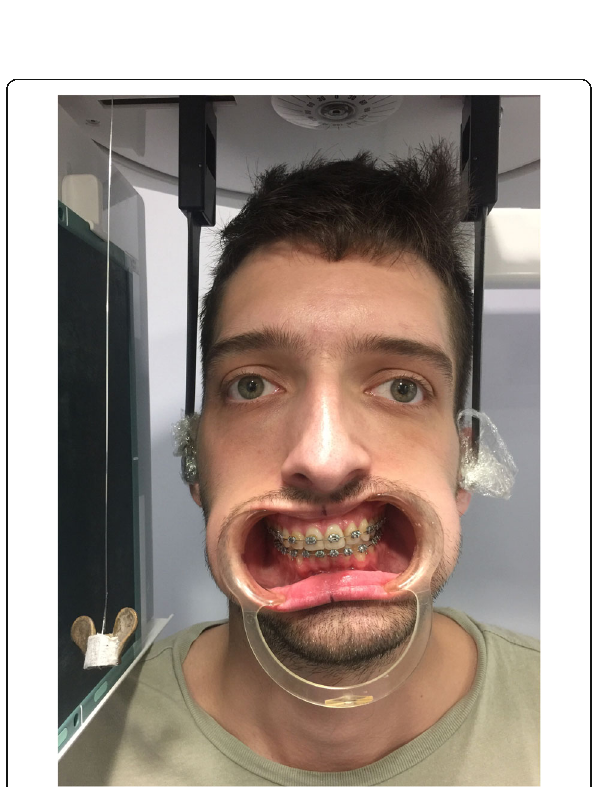
Fig. 2 Patient is shown in natural head position. The oral retractors are in situ, and a plumb line is evident hanging to the patient ’ s right side, which acts as a guide to the true vertical line. A transverse cant of the maxillary occlusal plane, down on the patient ’ s right side, is evident. The patient may be positioned in a cephalostat as demonstrated here, though this is not mandatory, and for most patients sitting in the dental chair will suffice